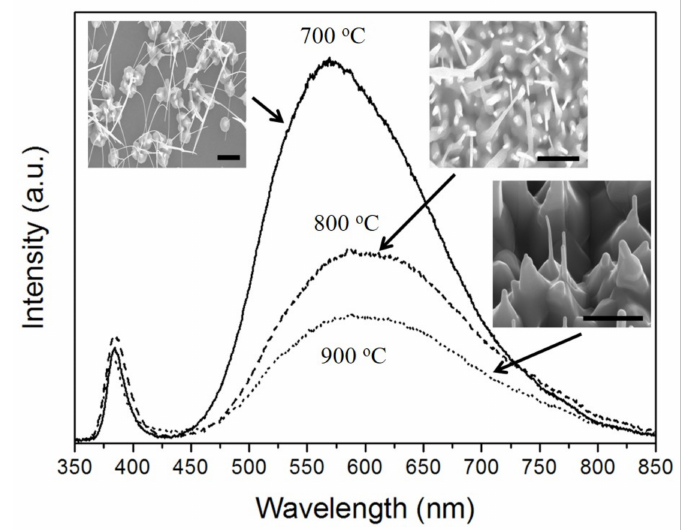
Figure 5. PL spectra of the ZnO double-structured rods grown for a growth time of 60 min under different growth temperatures. The insets correspond to Figure